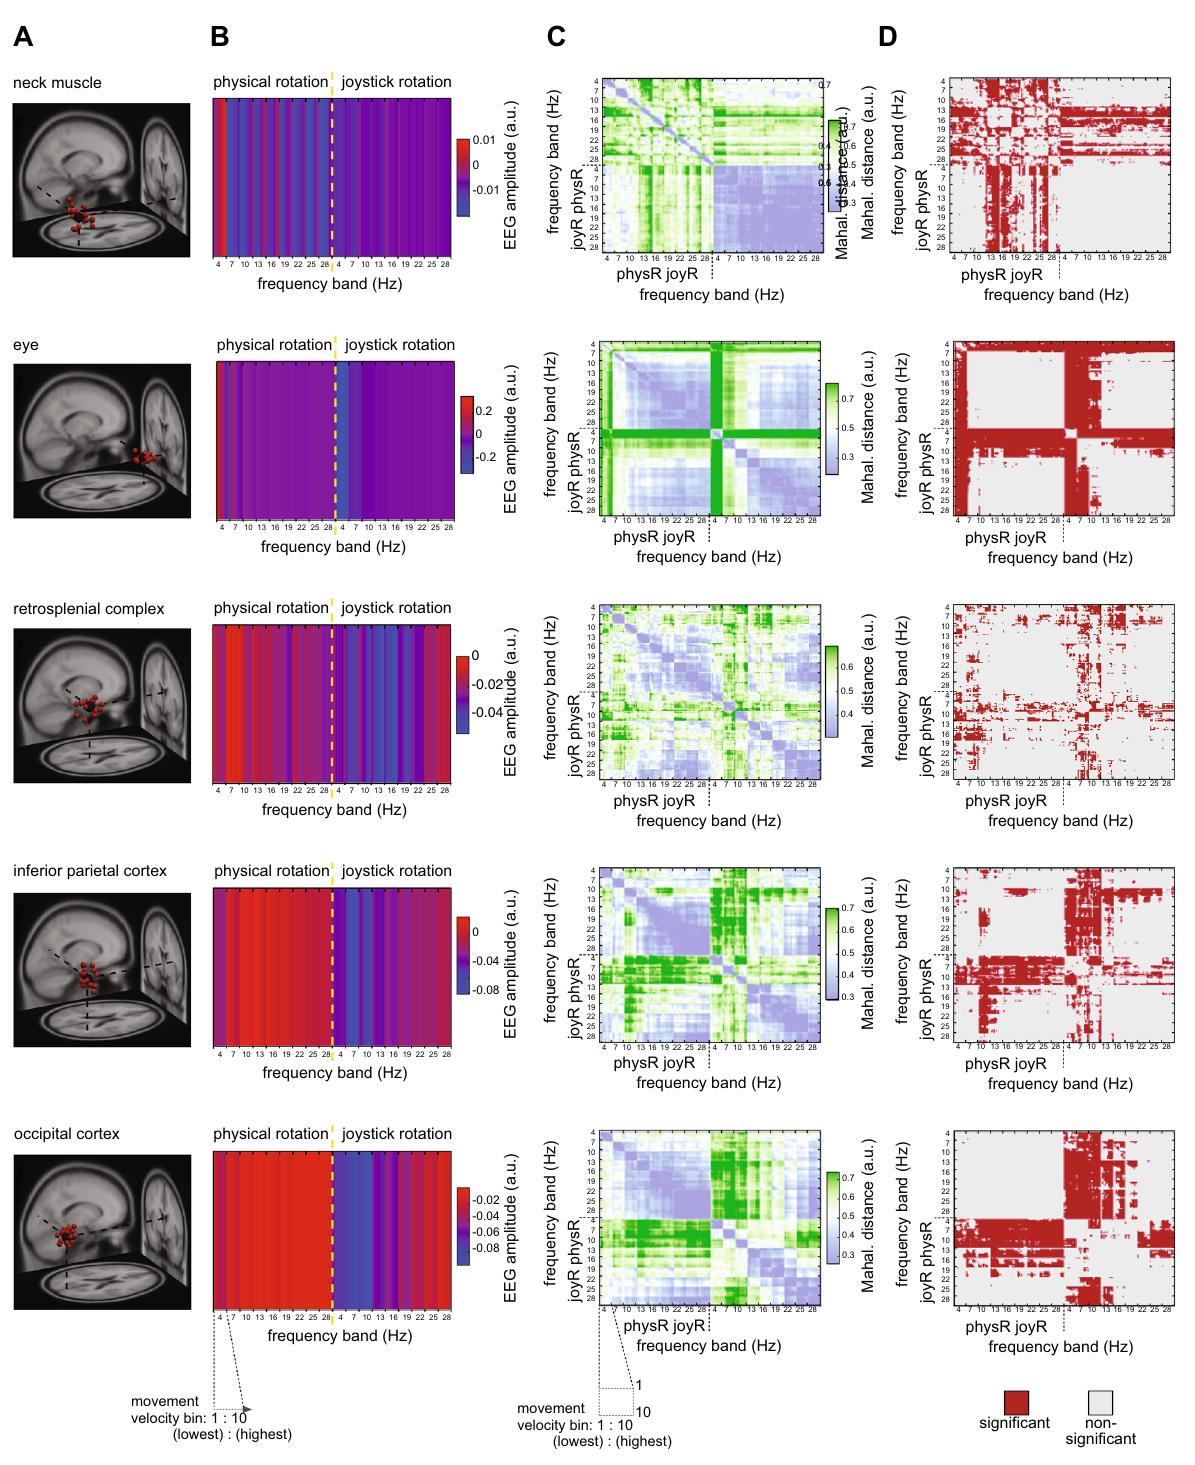
Figure 2. Representational Similarity Analysis (RSA) of movement velocity-associated modulation of oscillatory activity in the right neck cluster. ( A ) 3D-projection of IC-clusters onto a standard brain (described in detail in Fig. 1). ( B ) Grand-average IC amplitudes across all ICs in the cluster sorted according to velocity bins from lowest velocity to highest velocity; color bar is scaled to min. and max. Displayed are the start categories of each frequency band (9 bands; non-overlapping 2.5 Hz steps), and each frequency band contains, in ascending order, 10 movement velocity bins (percentiles; 10–100% referring to slowest and largest velocities, respectively). ( C ) Grand-average normalized Mahalanobis distance (Representational Dissimilarity Matrix, RDM); color bar is symmetrically scaled to 85% of the max. value; the normalized Mahalanobis distance scales from 0 (no distance) to 1 (max. distance), values of ~ 0.5 are obtained on randomly shuffled data. ( D ) RDM statistical significance (tested vs. noise level, permutation testing with n = 10,000 permutations, p = 0.05) for the outward rotation (movement onset to offset). FDR false discovery rate, IC independent component, RDM representational dissimilarity matrix, RSA representational similarity